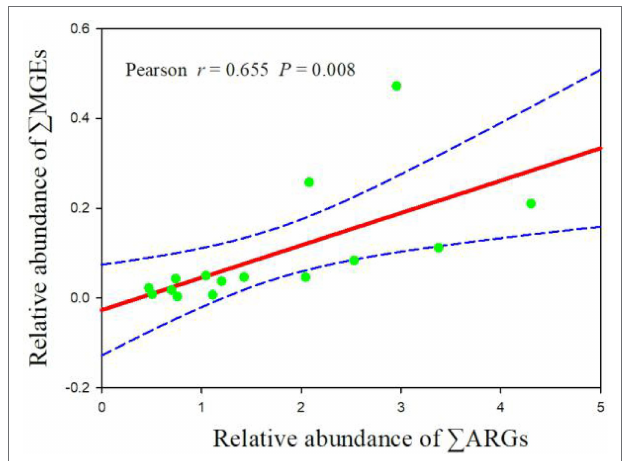
FIGURE 2 | Correlation between the relative abundance of total ARGs ( ∑ ARGs) and total MGEs ( ∑ MGEs). Total ARGs and total MGEs are the sum of the relative abundance values of all assays of that type in each sample.